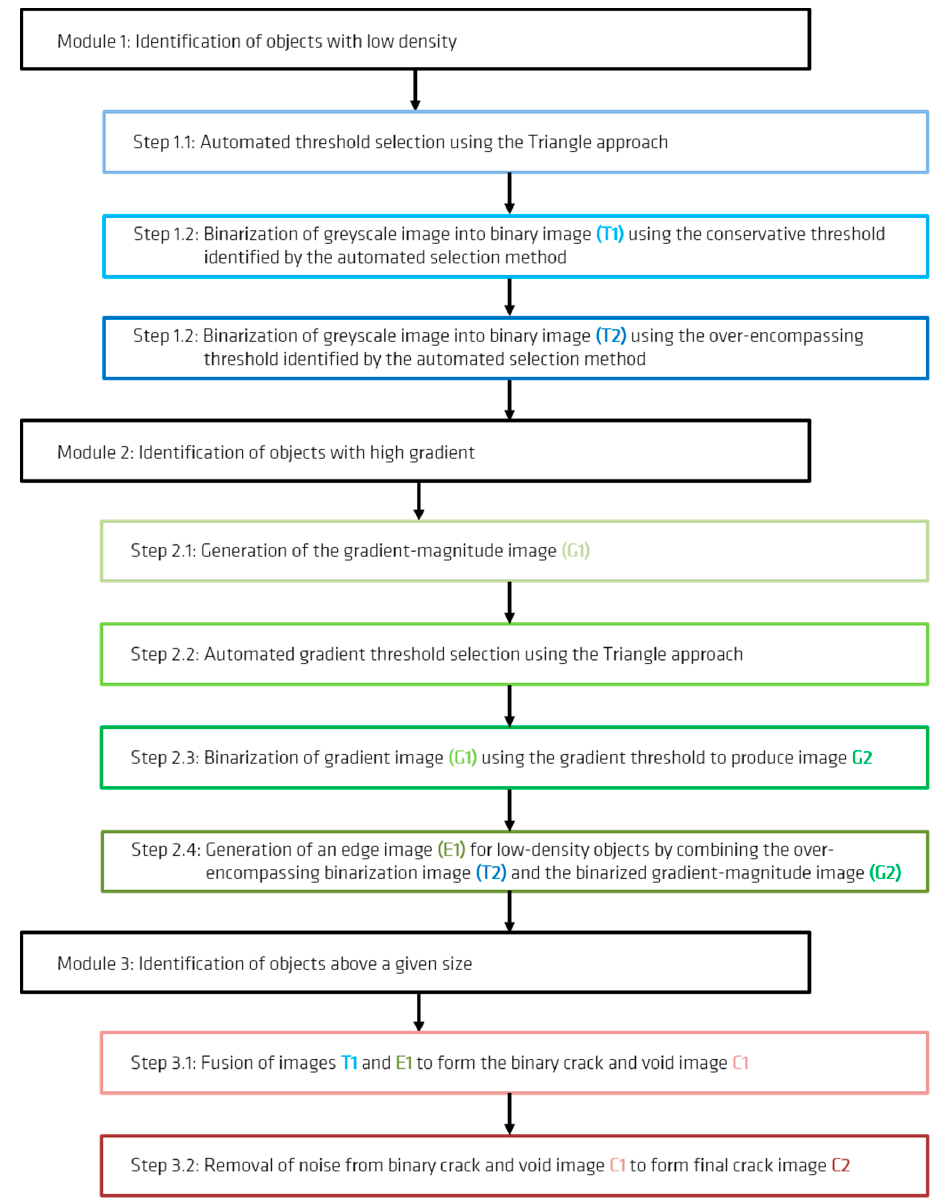
Figure 12. Flowchart of crack-detection process (based on figure in [10]).